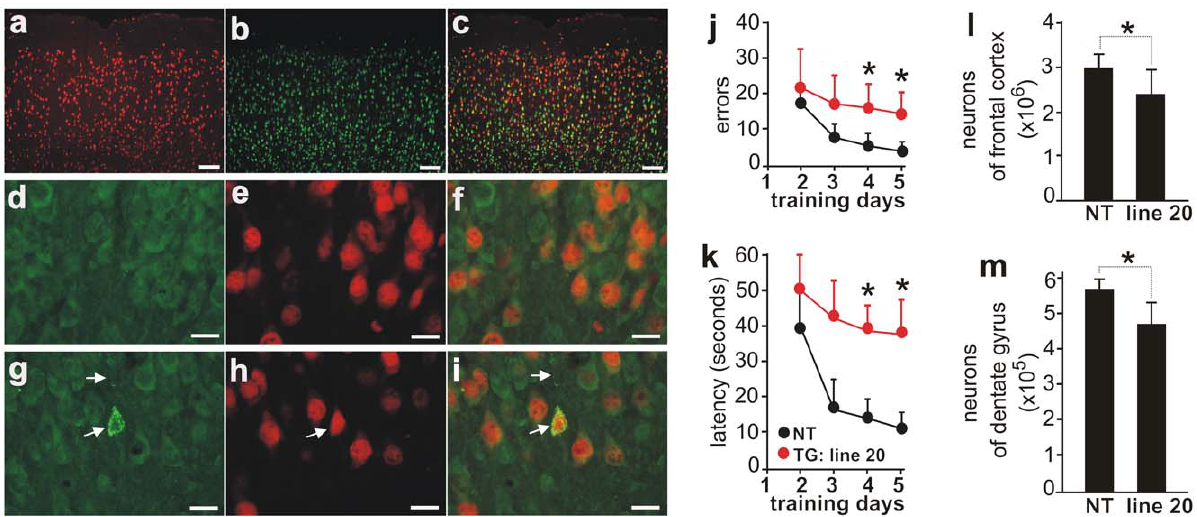
Figure 4. Neuron loss accompanied by ubiquitin aggregation in aged rats overexpressing the normal human fus gene. (A–C) Double- fluorescence staining for human FUS (A, red) and the neuronal marker NeuN (B, green) in the frontal cortex of normal human FUS transgenic rats (line 20). Most FUS-positive cells expressed NeuN, but some did not (C). (D–I) Immunofluorescence staining revealed ubiquitin aggregation in aged (G–I; 1 year of age), but not young (D–F; 3 months of age), normal FUS transgenic rats. Coronal sections of frontal cortex were immunostained with antibodies to ubiquitin (D, G: green) and human FUS (E, H: red). Scale bars: A–C, 100 m m; D–I, 20 m m. (J, K) Barnes maze analysis revealed spatial learning deficits in normal FUS transgenic rats of line 20 at advanced ages. One year old transgenic rats (TG) and their nontransgenic littermates (NT) were tested in a Barnes maze and time spent to locate the fixed escape hole (latency) and the number of errors made before escaping were recorded. (L, M) Stereological cell counting revealed a loss of neurons in the cortex (J) and dentate gyrus (K) of normal FUS transgenic rats at advanced ages (line 20). Coronal sections of one hemisphere were stained with Cresyl violet and the number of neurons in the frontal cortex and dentate gyrus was estimated by stereological cell counting. Normal FUS transgenic rats and their nontransgenic controls were killed at the age of 1 year. Data are presented as means 6 SD ( n =5). * p , 0.05.